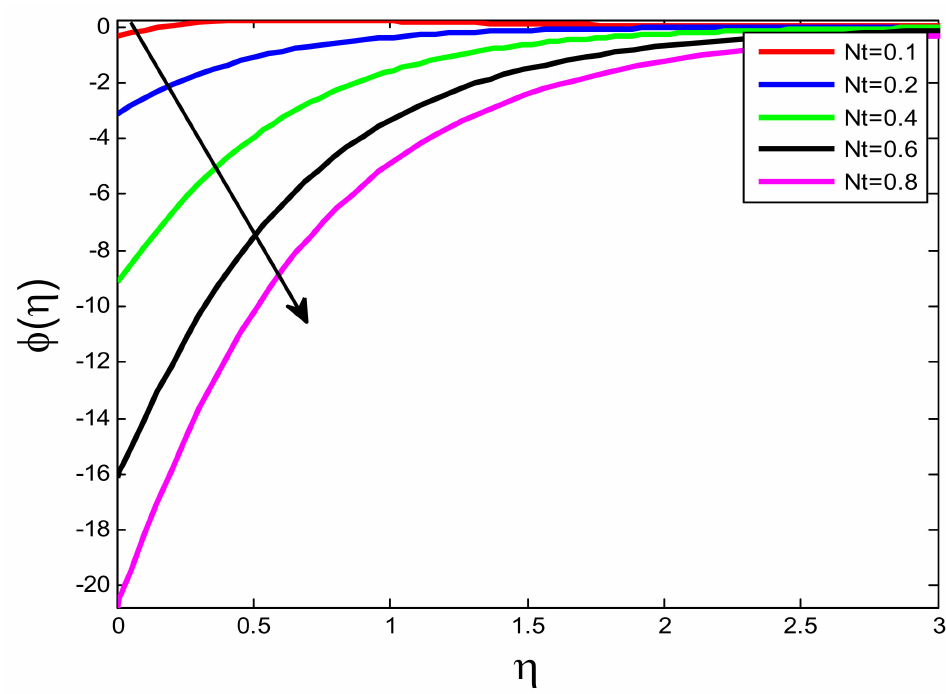
Figure 17. Influence of Nt on φ ( η )